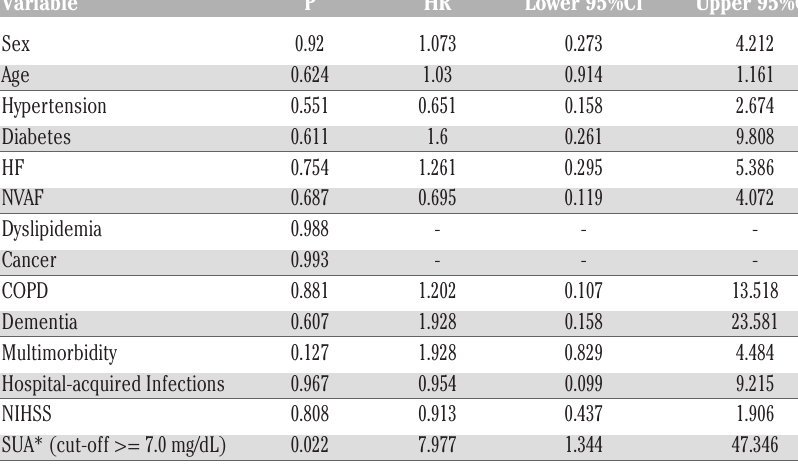
Table 3. Multivariate Cox regression analysis in the subpopulation with moderate-severe chronic kidney